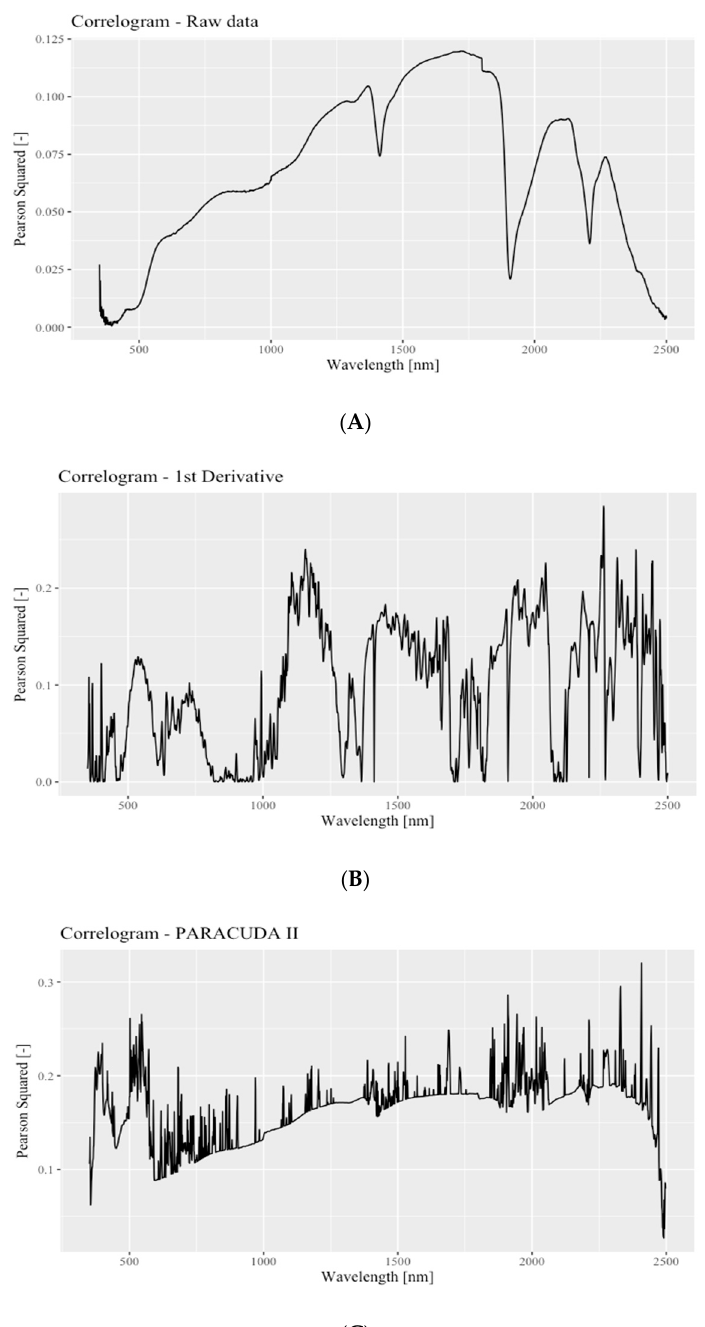
Figure 5. The correlogram of the spectra at ( A ) raw spectra, ( B ) after the 1st derivative, and ( C ) after the PARACUDA ‐ II ® preprocessing stage.